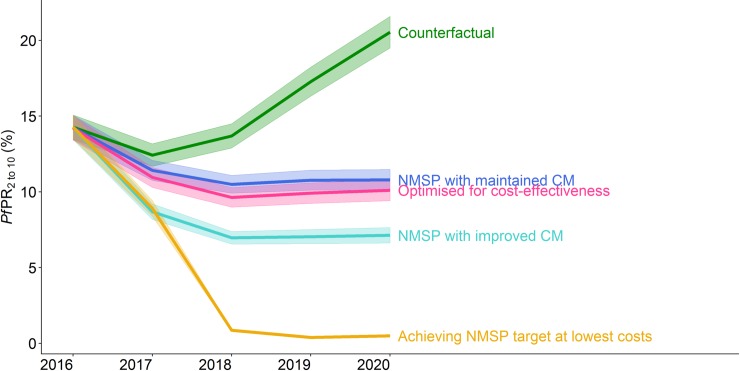
Predicted prevalence per strategy over time.The solid line shows the aggregated mean and the shaded area the 95% confidence interval based on heterogeneity among councils. The NMSP with maintained case management as well as the NMSP with improved case management refers to strategy 1, the most cost-effective intervention package to strategy 2, and the intervention package achieving the NMSP target to strategy 3. The counterfactual shows the simulated scenario with maintained case management levels and the discontinuation of vector control interventions.